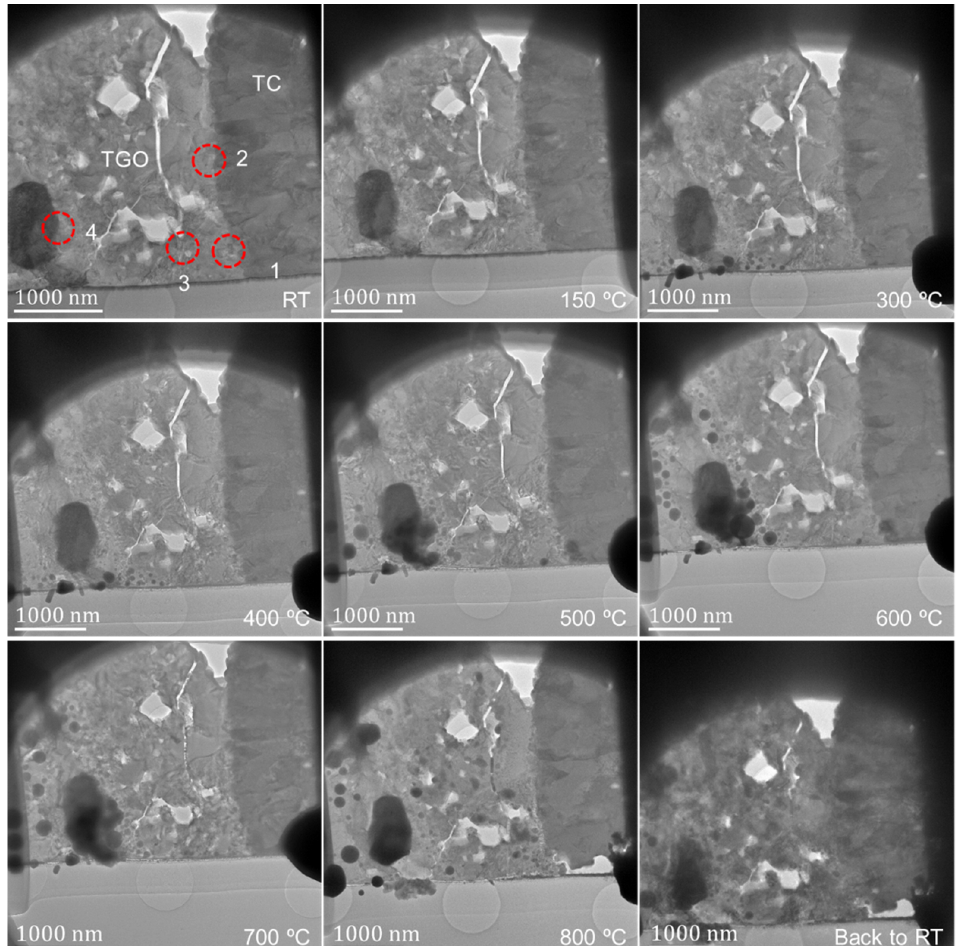
Figure 4. Morphology of the heated sample at different temperatures.